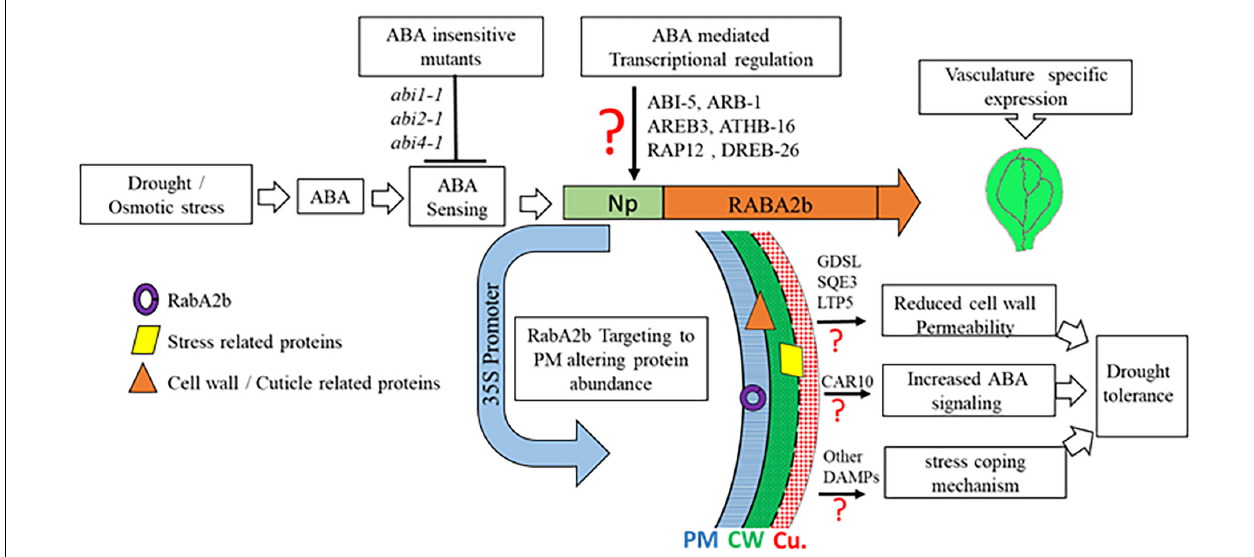
FIGURE 10 | RabA2b modes of action during water stress events. Under drought/osmotic stress ABA-insensitive mutants ( abi1-1 , abi2-1 , and abi4-1 ) shows a minimal expression of RabA2b gene which supports the fact that TF-binding to RabA2b promoter is facilitated by the family of ABA responsive adaptor proteins such as ABI1, ABI3, and ABI4. ABA induced expression of RabA2b is predicted to be mediated by an unidentified ABA-responsive transcription factors (TFs) binding to predicted TF-motifs present in its promoter. However, the plants over-expressing RabA2b under constitutive promoter (CaMV-35S promoter) shows enhanced drought-tolerant phenotype. The microscopic and proteomic studies suggest RabA2b enhance vesicle trafficking toward plasma-membrane (PM) which altered protein localization in the PM/apoplastic region of GDSL, SQE3, and LTP5 resulting in a customized cell wall and cuticle. Nevertheless, their direct role in cuticle modifications needs further validation. These changes in the OE lines modulate surface permeability and prevent non-stomatal water loss, making these plants more tolerant to drought stress. In addition, increased RabA2b trafficking increasing the abundance of CAR10, which is known to facilitate the recruitment of ABA receptor on plasma-membrane. Therefore, it can be speculated that the RabA2b OE plant possess improved ABA sensing or signaling. Apart from these mentioned protein, several other protein identified in the proteomics studies have been reported to provide drought tolerant phenotype ( Table 1 ) therefore possibly playing a role in drought resistance through other unknown stress coping pathways. CU, cuticle; PM, plasma-membrane; CW, cell wall, red question mark (?) represents the need of further confirmations.